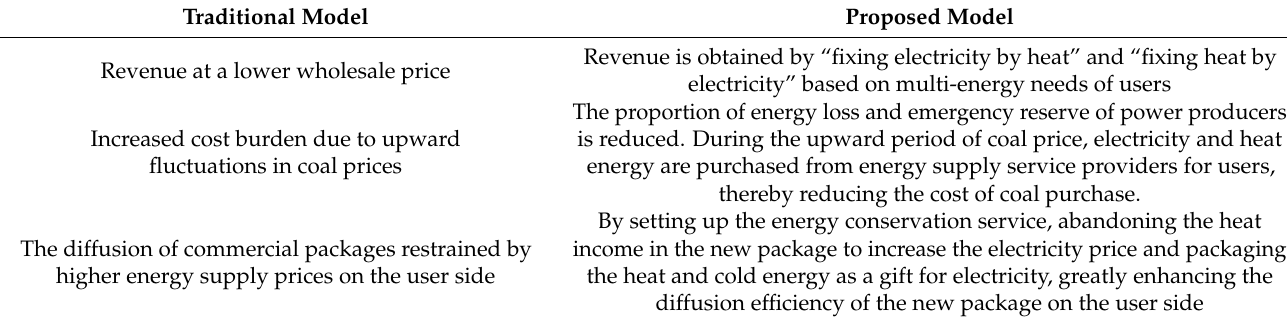
Table 9. Comparison between the traditional model and the proposed